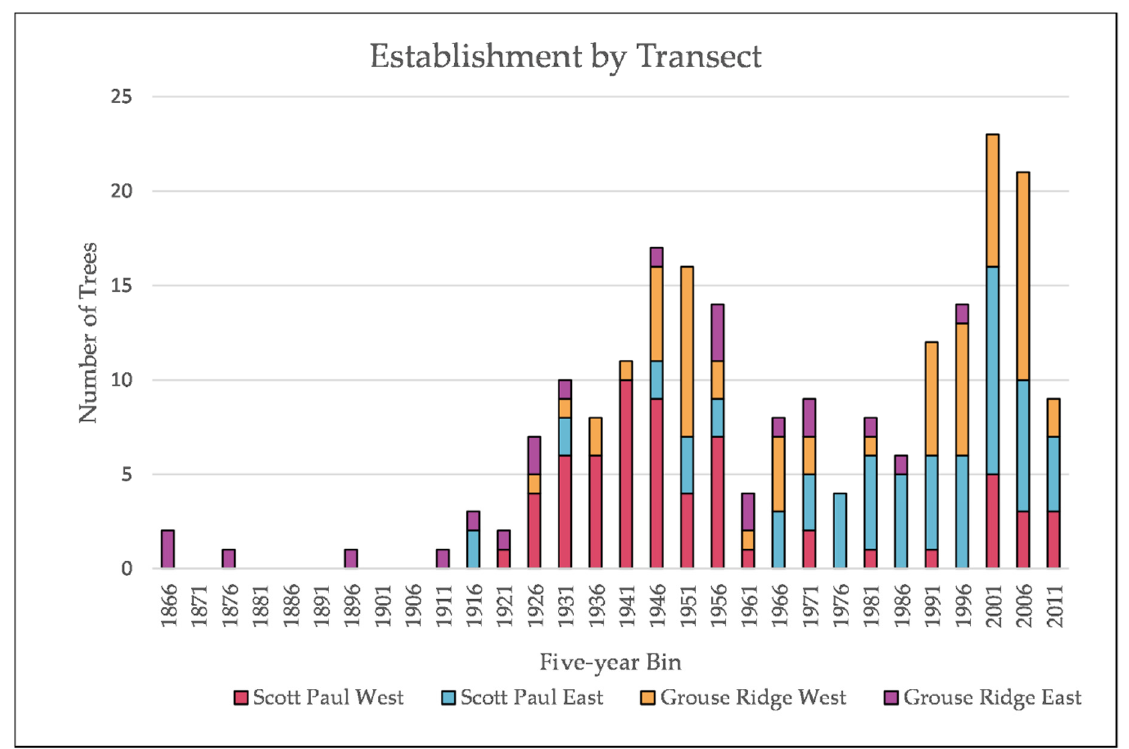
Figure 3. The number of trees established in each five-year bin at each transect. The dates on the graph are the start dates of each five-year bin.